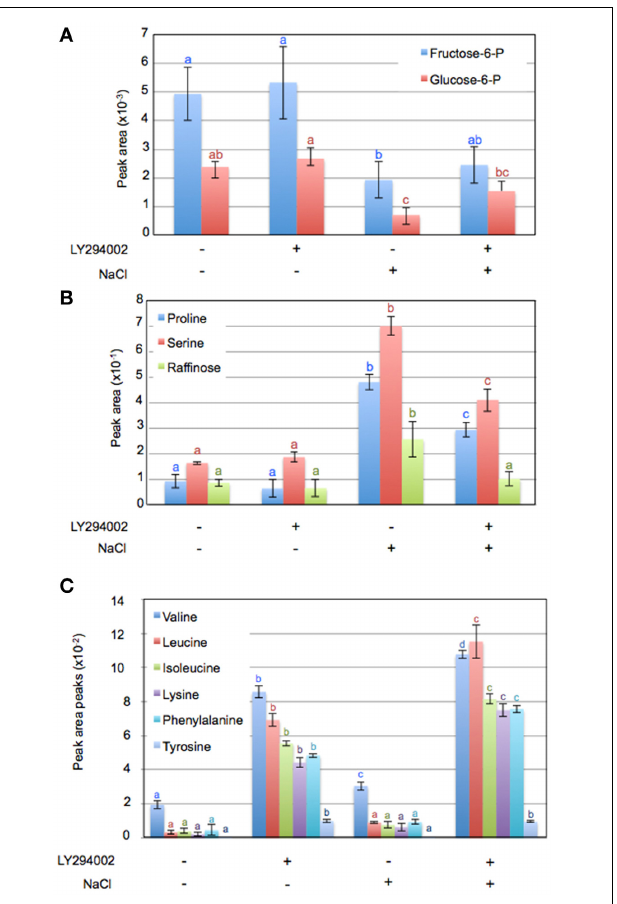
FIGURE 7 | Variation of metabolite content in Arabidopsis seedlings in response to salt stress with or without LY294002. Metabolite contents of 12-days-old Arabidopsis wild-type seedlings treated during 24h as explained in Materials and Methods. Values in (A–C) are computed from normalized areas of specific peaks after GC-MS experiments (see Materials and Methods for details) and are the means ± SD of three independent repetitions. Letters in (A–C) indicate statistical differences in metabolite levels depending on treatment conditions (Two-Way ANOVA test, P < 0 .